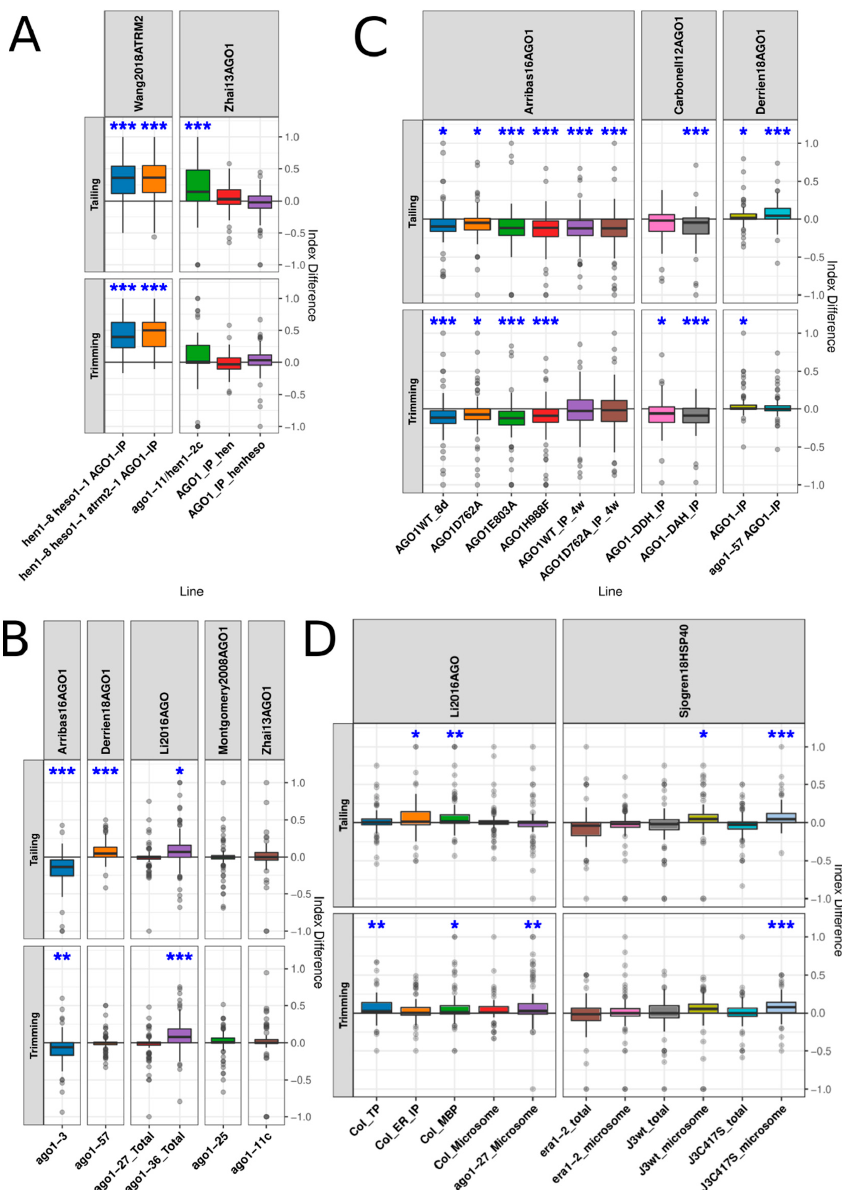
Figure 3. The analyses of AGO1 mutant plants, immunoprecipitations, and cellular fractions showed the relevance of this protein and its location for miRNA turnover: ( A ) distribution of guide miRNA IDs in AGO1 immunoprecipitation in mutant backgrounds of genes related to miRNA turnover, where the IDs of IPs from Zhai et al. [31] were contrasted against the sequencing of input material in the corresponding mutant background; ( B ) distribution of guide miRNA IDs in different AGO1 mutants, where the reference line for ago1-3 was the same mutant complemented with FLAG-AGO1; ( C ) distribution of guide miRNA IDs in AGO1 IPs of WT and slicer-defective proteins, where in the AGO1 study performed by Arribas et al. [49], 8d indicates 8 days after germination, 4w indicates 4 weeks after germination, TP indicates total polysomes, and MBP indicates Microsome-Bound Polysomes and where the reference line and the rest of the samples were taken from 12 days-after-germination plants; and ( D ) distribution of guide miRNA IDs in different subcellular fractions and mutants, where in the Sjogren et al.’s [51] study, the ID was calculated with respect to different reference lines: total miRNAs were contrasted with the WT total fraction, while microsomal fractions were compared to the WT microsomal fraction. Asterisks over the boxplots indicate the results of paired t-tests between the mean index of the line and that of the reference line, paired by miRNA; * p -value below 0.05, ** p -value below 0.01, and *** p -value below 0.001. The tests were grouped by the modification evaluated, trimming or tailing, and p -values were FDR-corrected across all studies analyzed in this work.